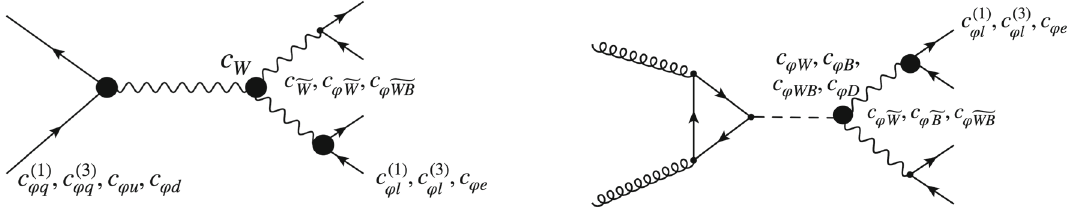
Fig. 2 Same as Fig. 1 for two representative EFT diagrams contributing to diboson production: a pure diboson diagram (left) and another for which diboson production interferes with the h → V V process